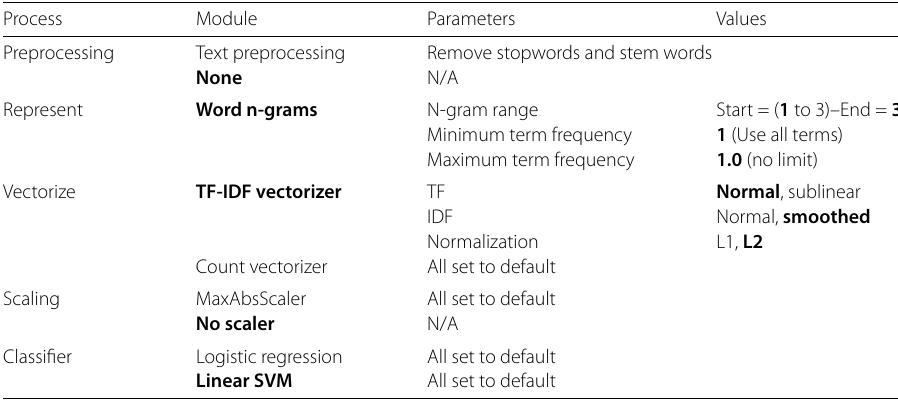
Table 5 Parametrization of character n-grams models. Optimal settings are typeset in bold Process Module Parameters Values Represent Character n-grams N-gram range Start = ( 1 to 5)–End = 5 Minimum term frequency [ 0.05 , 0.1, 0.5] Maximum term frequency 1.0 (no limit) Vectorize TF-IDF vectorizer TF Normal, sublinear IDF Normal, smoothed Normalization L1, L2 Count vectorizer All set to default Scaling MaxAbsScaler All set to default No scaler N/A Classifier Logistic regression All set to default Linear SVM All set to default